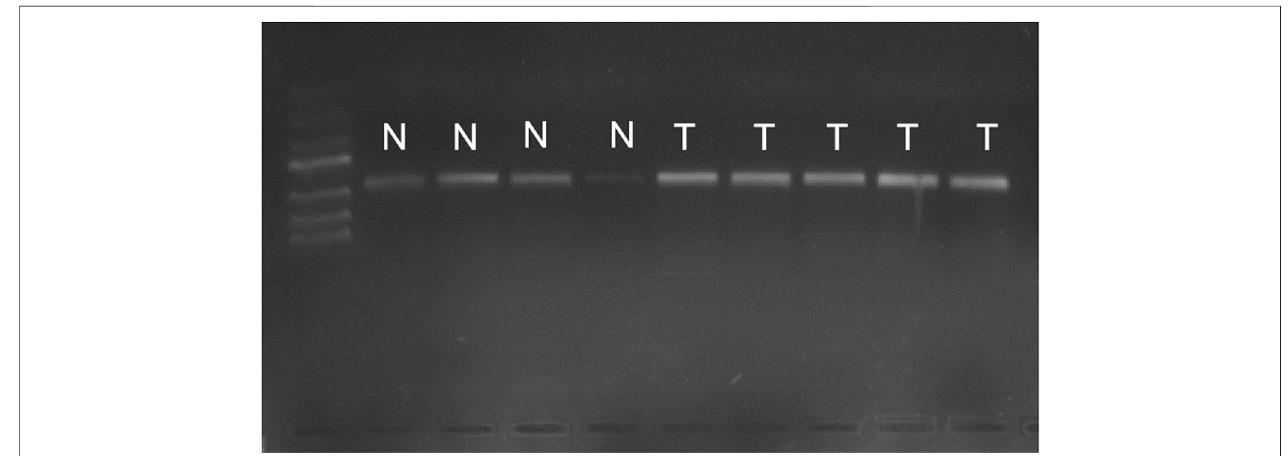
FIGURE1| PCRresultsofcancertissues andadjacenttissues.BandsofPCRinboththecanceroustissue andtheparacancertissueN,normalbladdertissurs. T, bladder tumor tissues.